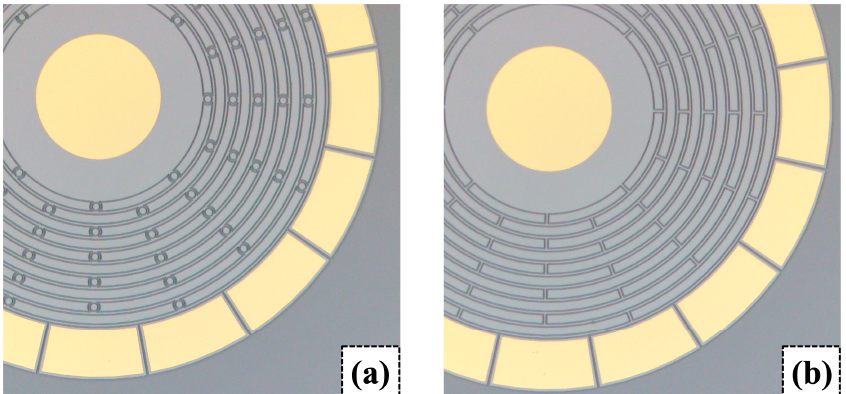
Figure 11. Manufactured resonant structure and electrode pads of ( a ) designed resonator with elliptic spokes, and ( b ) conventional resonator with linear spokes under microscope.